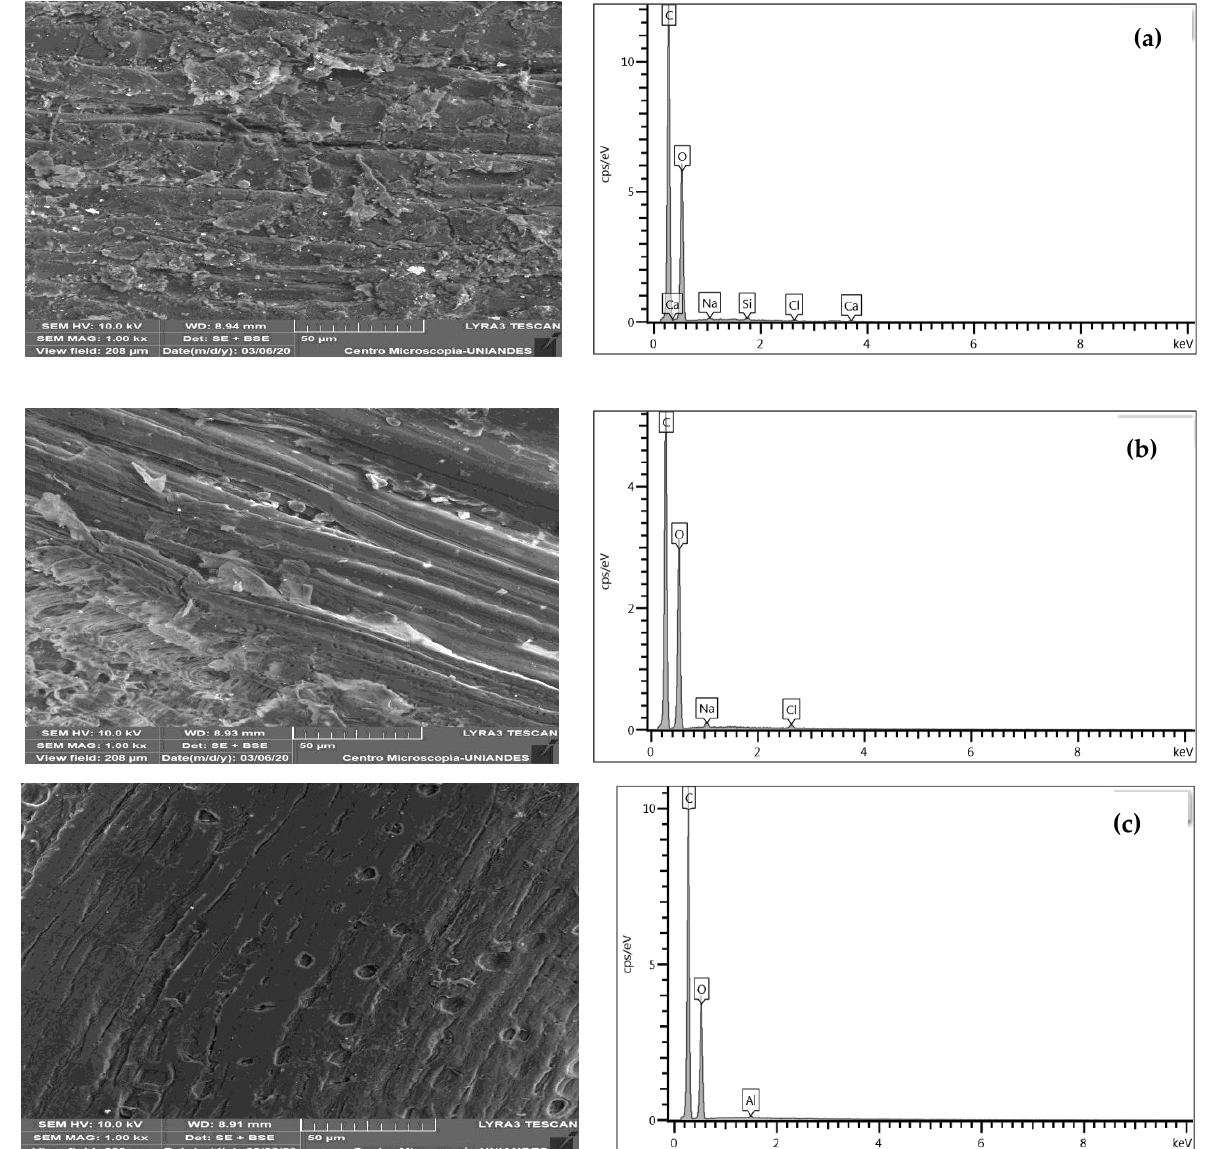
Figure 3. SEM micrographs and EDS spectra of ( a ) CM, ( b ) CC and ( c ) MCC.